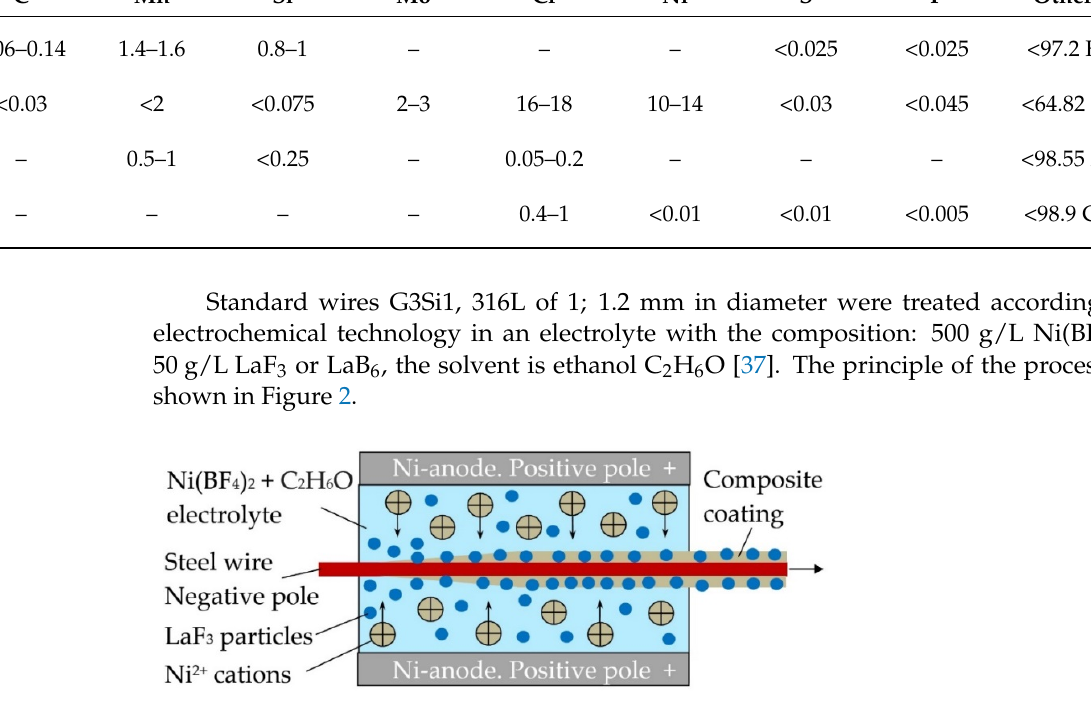
Figure 3. SEM image of the microstructure of composite Ni-LaF 3 coatings on the surface of the wire. Sulfur hexafluoride SF 6 : SF 6 > 99.9%, H 2 O < 5 ppm, CF 4 < 500 ppm, air < 500 ppm (Linde AG, Pullach, Germany) was introduced into pure argon through a WITT KM gas mixer 80-3 (WITT-Gasetechnik GmbH, Witten, Germany) in the ratio, %: 1.6; 3.2; 4.8; 6.4. SF 6 concentrations were calculated taking into account the volume and molar mass. Investigations of the droplet transfer were carried out by the shadow method using a laser system when weld deposition on a rotating pipe. Video recording was made with a high-speed video camera Phantom V310 (Vision Research Inc., Wayne, NJ, USA) at 2000 fps. Phantom CV software (Vision Research Inc., Wayne, NJ, USA) was used for image